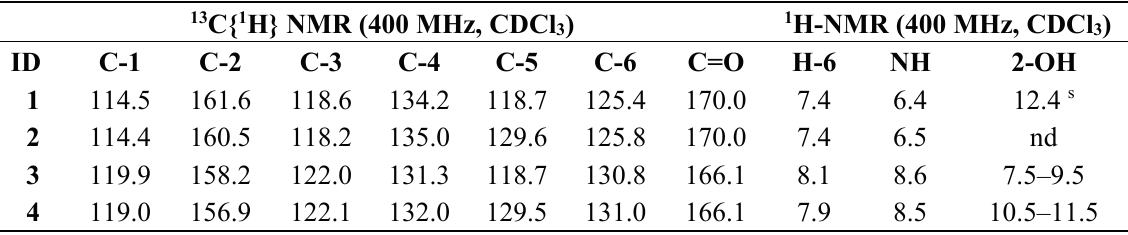
Table 2. Selected 13 C/ 1 H chemical shifts ( δ ) of compounds 1 – 4 .